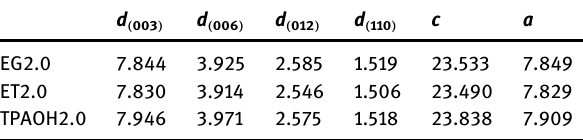
Table 1: The interplanar spacing and lattice parameters of LDH ( Å )